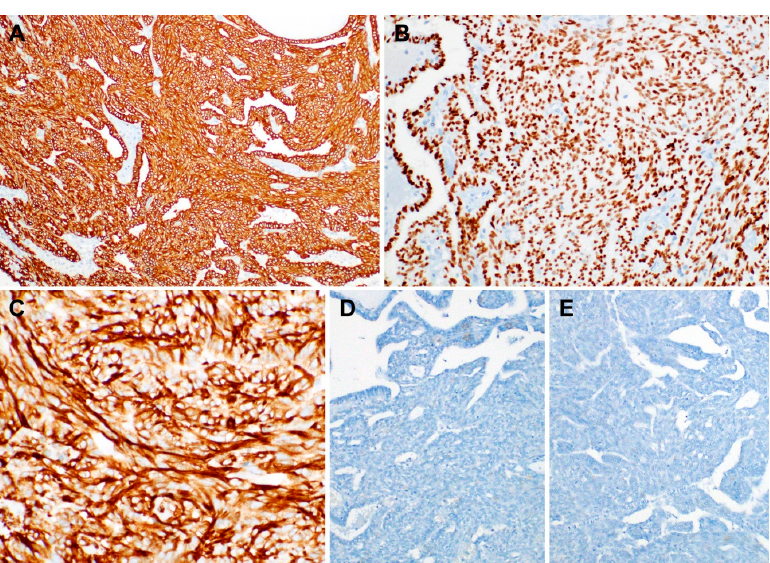
Figure 4. Immunophenotype of biphasic thyroid-like low-grade nasopharyngeal papillary adenocarcinoma. Both papillary and stromal cell components tested uniformly and strongly positive for ( A ) cytokeratin 7, ( B ) thyroid transcription factor-1, and ( C ) vimentin. In contrast, the tumor cells did not express ( D ) thyroglobulin and ( E ) BRAF V600E. Polymer method. Original magnification: A and B, 100×; C, 200×; D and E,